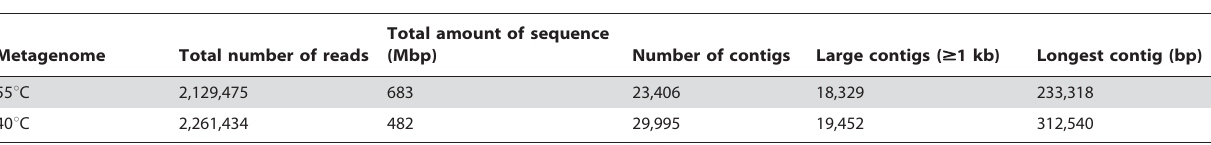
Table 2. Metagenome summary statistics.